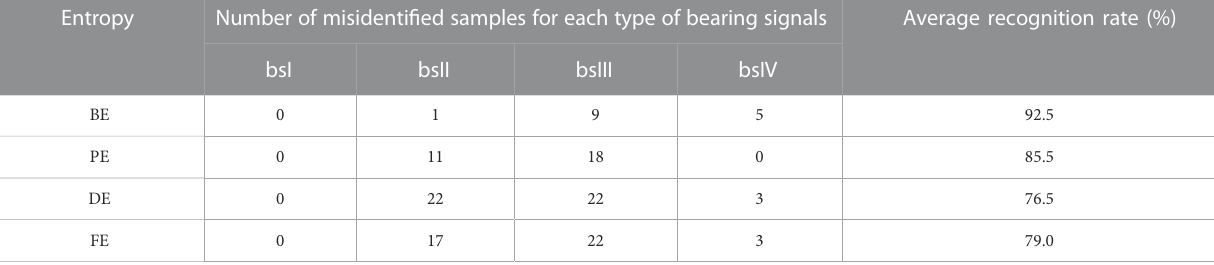
TABLE 3 Feature classi fi cation and recognition results obtained for